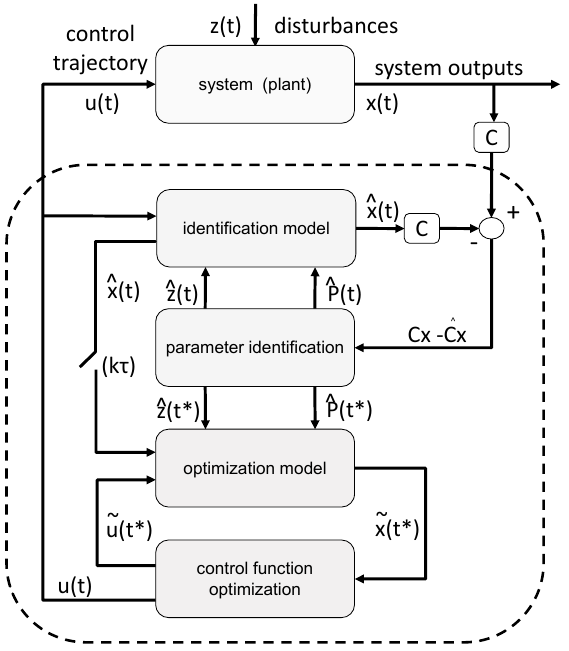
Figure 1. Workflow for the Nonlinear Model Predictive Control (NMPC) cycle. Followed by a model parameter estimation, the process input (here, the feed profile) is optimized (adapted from [6,9,43]). Features of the applied NMPC process control: